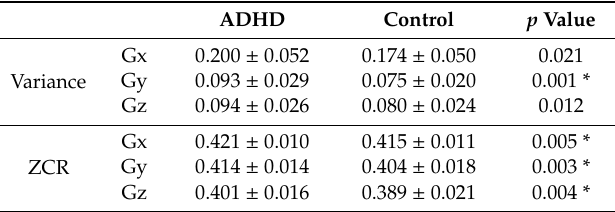
Table 3. Comparison of the accelerometer measurements between the attention-deficit hyperactivity disorder (ADHD) and control groups. ADHD